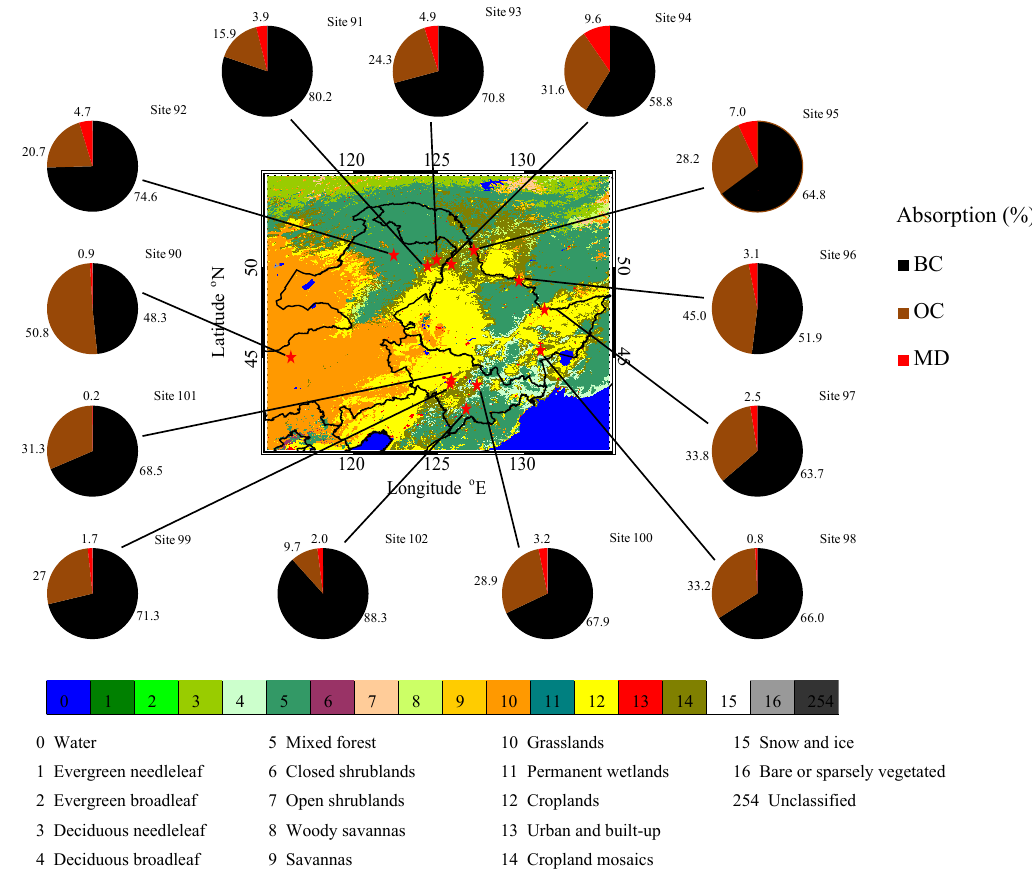
Figure 7. The light absorption of ILAPs in surface snow in January 2014. The distribution of 17 different surface vegetation types retrieved from MODIS global land cover type product (MCD12C1) with 0.05 spatial resolution were used in this